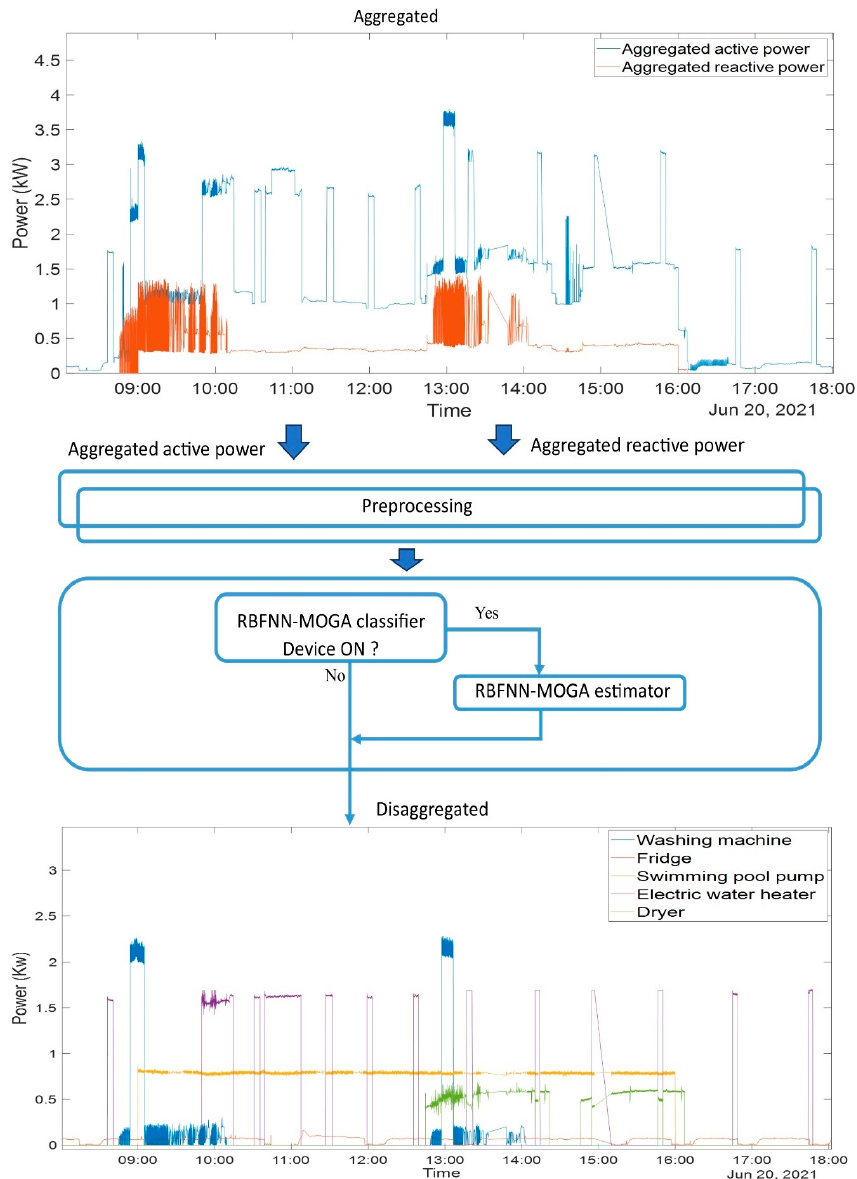
Figure 2. Overview of the proposed approach.